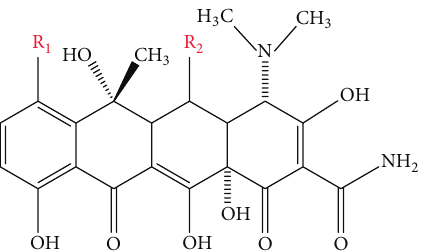
Figure 1: The overall structure of tetracycline antibiotics: tetracy- cline(R 1 ,H;R 2 ,H);chlortetracycline(R 1 ,Cl;R 2 ,H);oxytetracycline (R 1 , H; R 2 ,